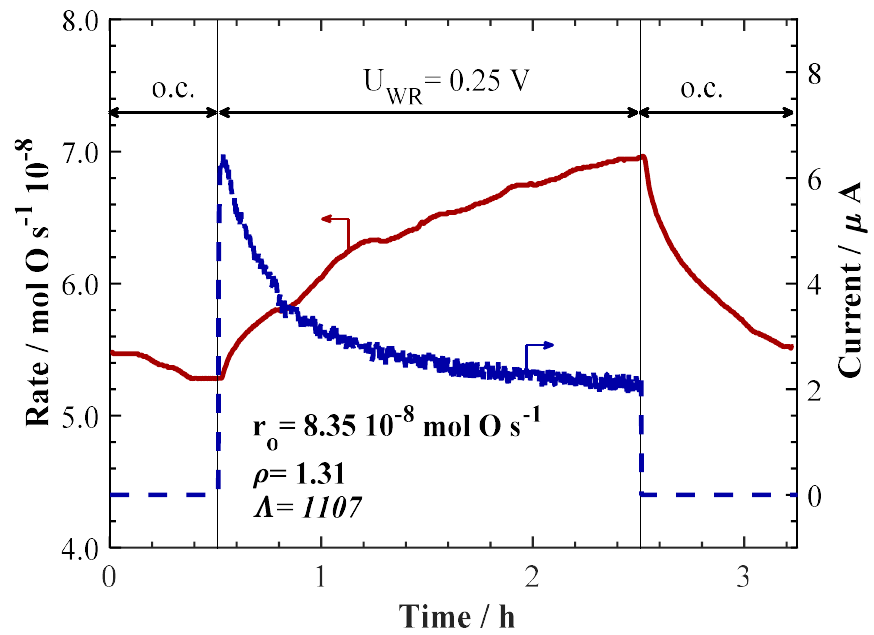
Figure 5. Transient rate response of Pd nanoparticles to potential step changes. o.c.: open-circuit. Conditions: T = 425 °C, 2 kPa of CH 4 and 4 kPa of O 2 . Flow rate: 100 ccm.